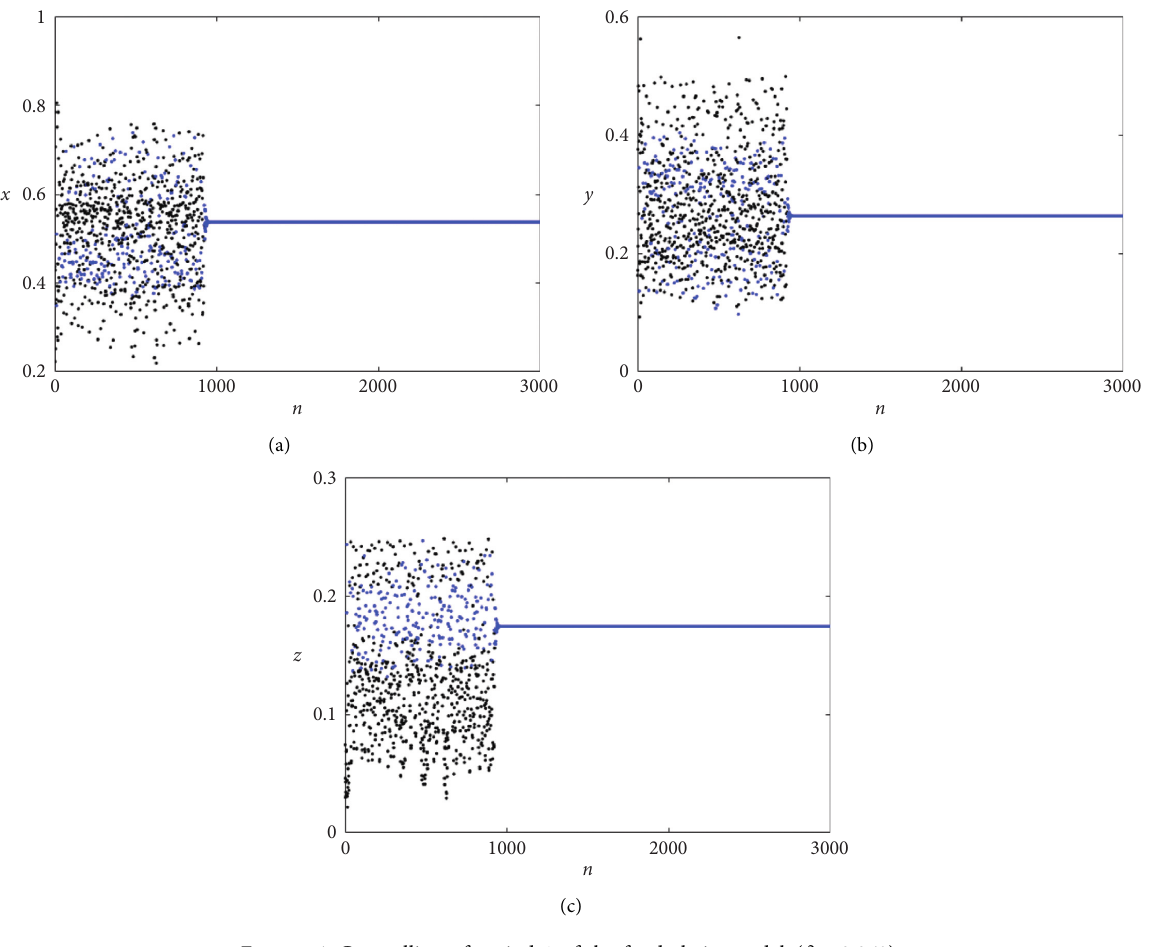
Figure 6: Controlling of period-1 of the food chain model ( δ � 0 . 063 )